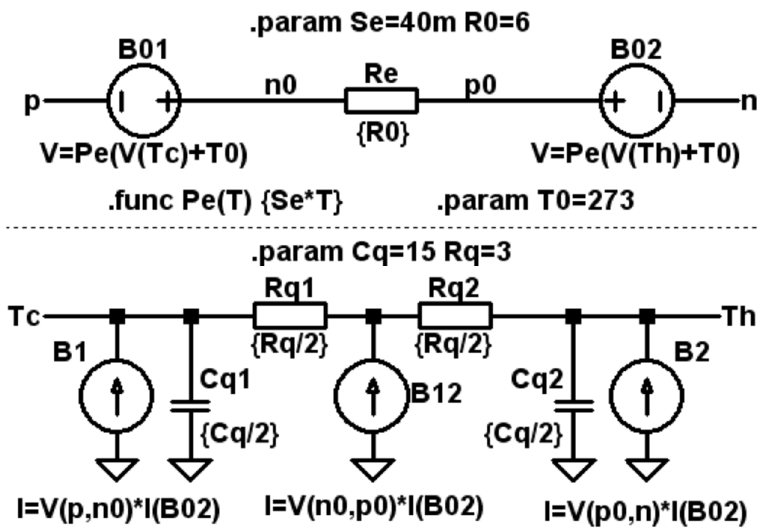
Figure 1. Kubov’s LTspice TEG model; Top part: Electrical, Bottom part: Thermal.